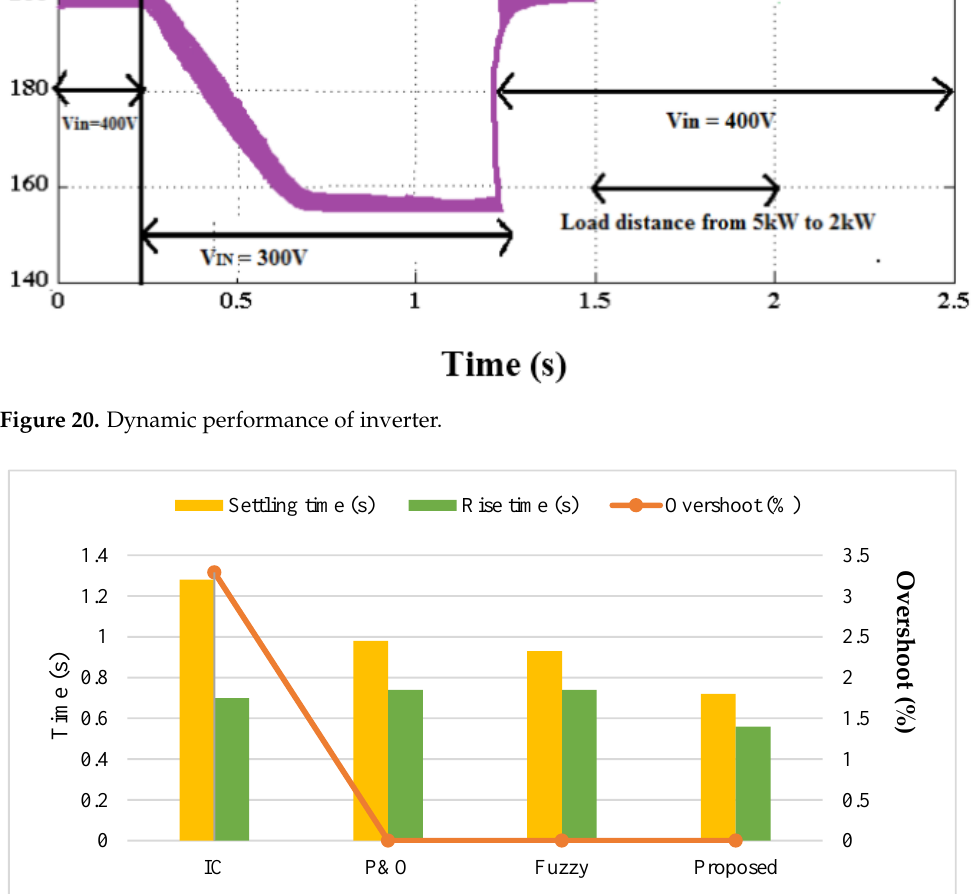
Figure 20. Dynamic performance of inverter.